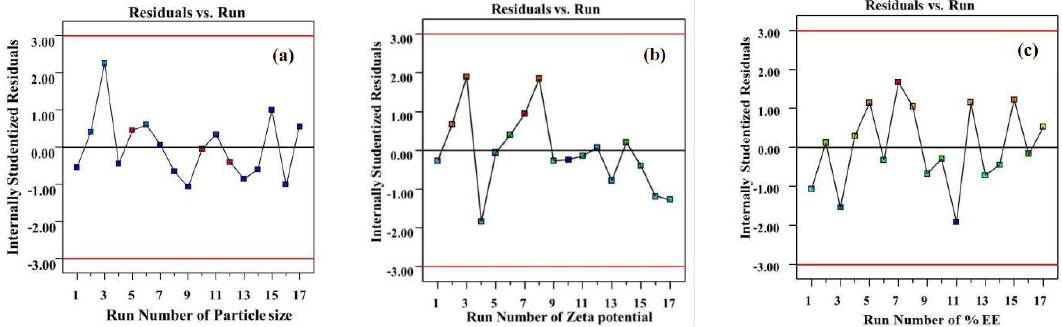
Figure 3. The corresponding residual plot between the run number and the internally studentized residuals for various responses of particle size ( a ); zeta potential ( b ); and % EE ( c ).